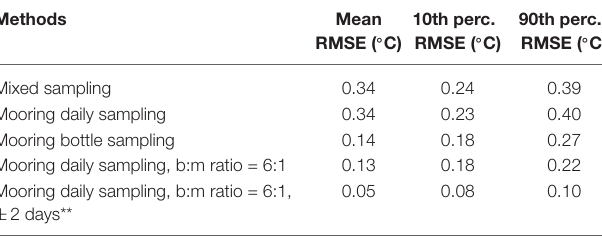
TABLE 3 | A comparison of the temperature Root Mean Square Errors (RSMEs, ◦ C) between the synthetic climatology statistics using different